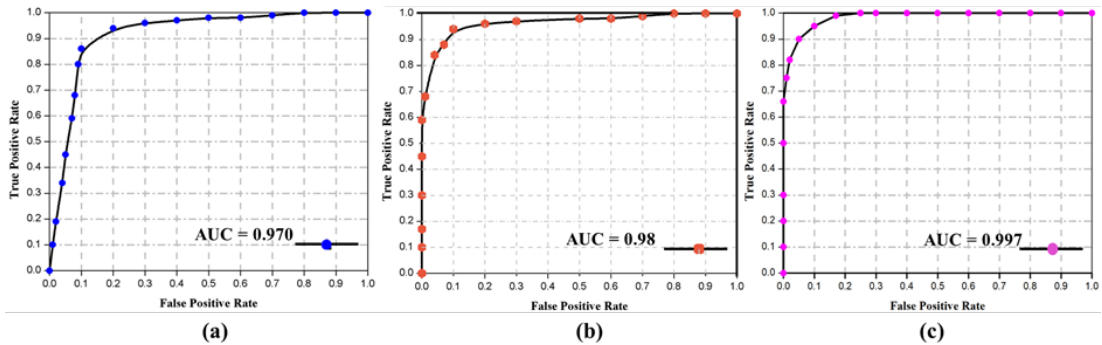
Figure 8. The ROC curve and comparison amongst the datasets based on AUC value, i.e., ( a ) Hockey fight dataset; ( b ) Violent crowd dataset; and ( c ) Violence in movies dataset. Table 6. Precision and recall with AUC values are compared for each dataset.